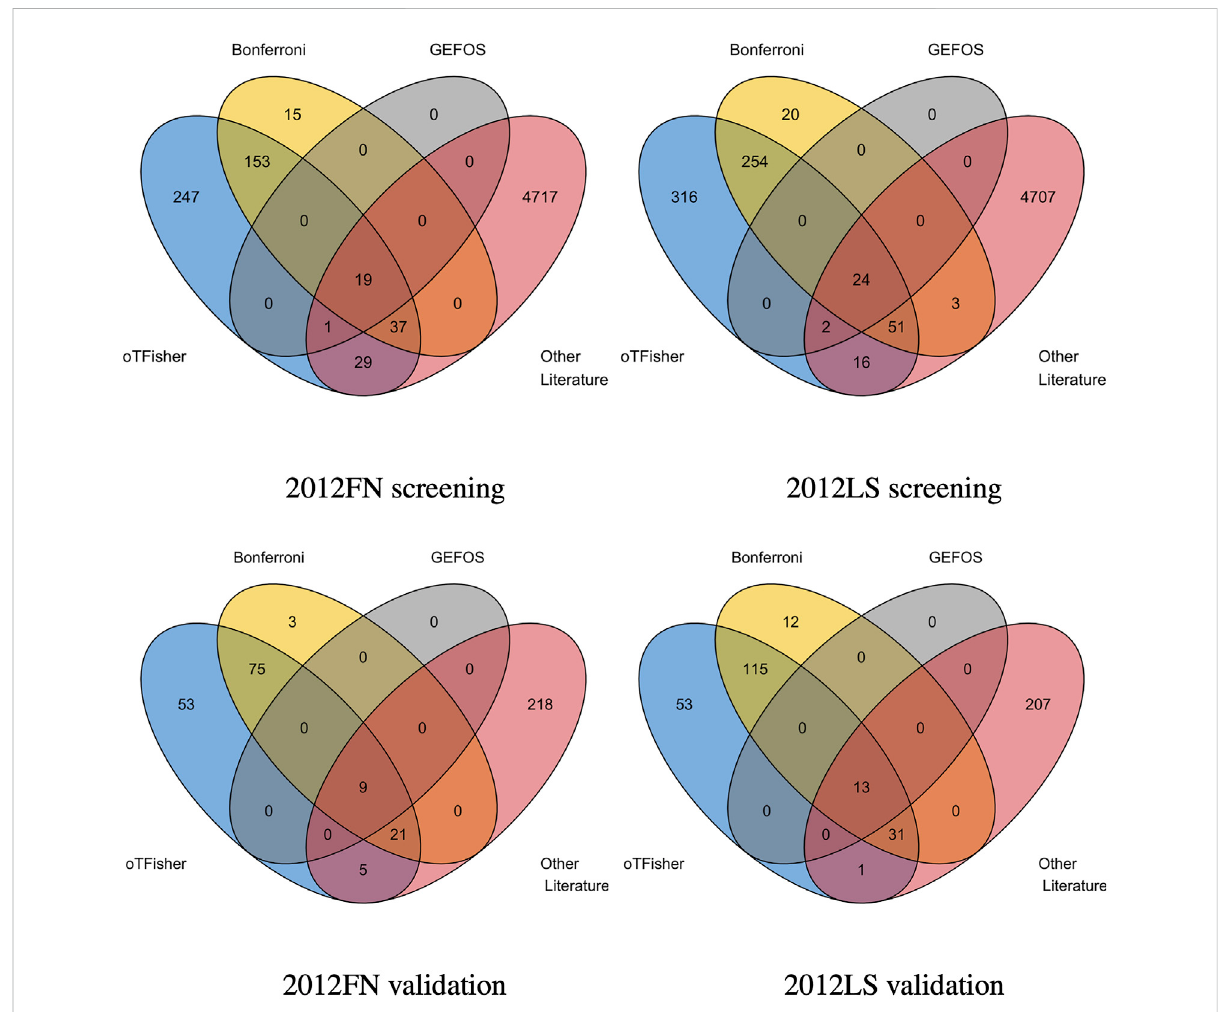
FIGURE 7 Overlap the screened SNPs in haploblock-based analysis (row 1) and validated SNPs (row 2) based on the oTFisher_r, Bonferroni procedure, originalGEFOSstudy,andliterature.SNPscreeningisdonebyGEFOS2012_FN(leftcolumn)andGEFOS2012_LS(rightcolumn);validationisdoneby the UK Biobank